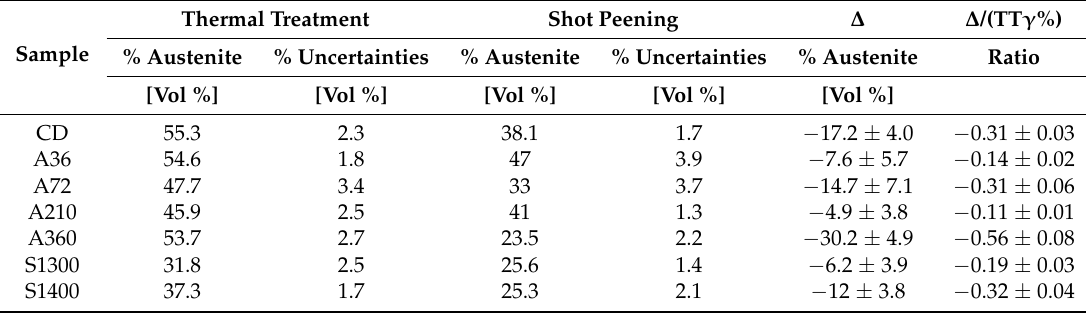
Table 4. Austenitic phase volume fraction measured via XRD technique in the same areas of the specimens, before and after shot peening process.